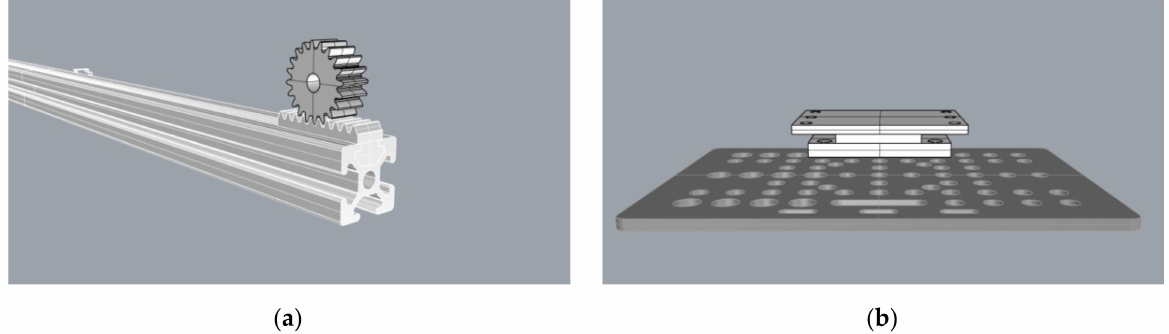
Figure 6. ( a ) Gear/rack graphic designs on the V-Slot extrusion and; ( b ) Z axis motor base design on the V-Slot wagon.